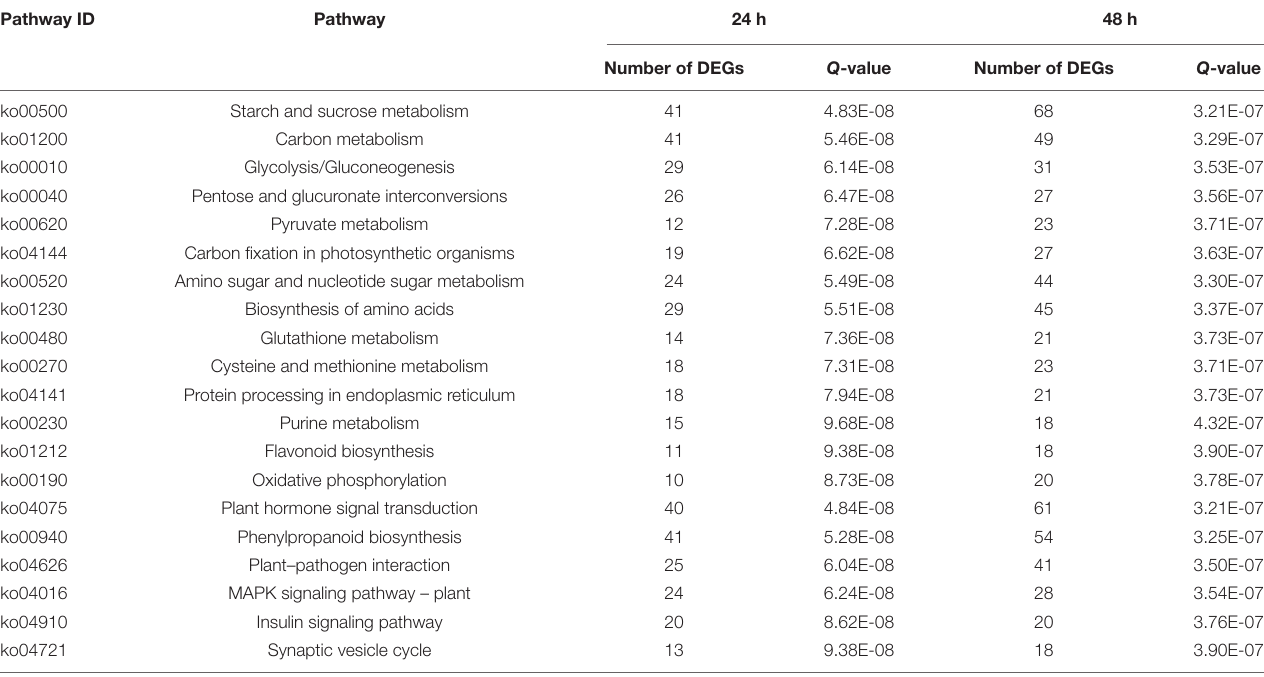
TABLE 2 | The top 20 enriched KEGG pathways for DEGs in 24 h and 48 h. Pathway ID